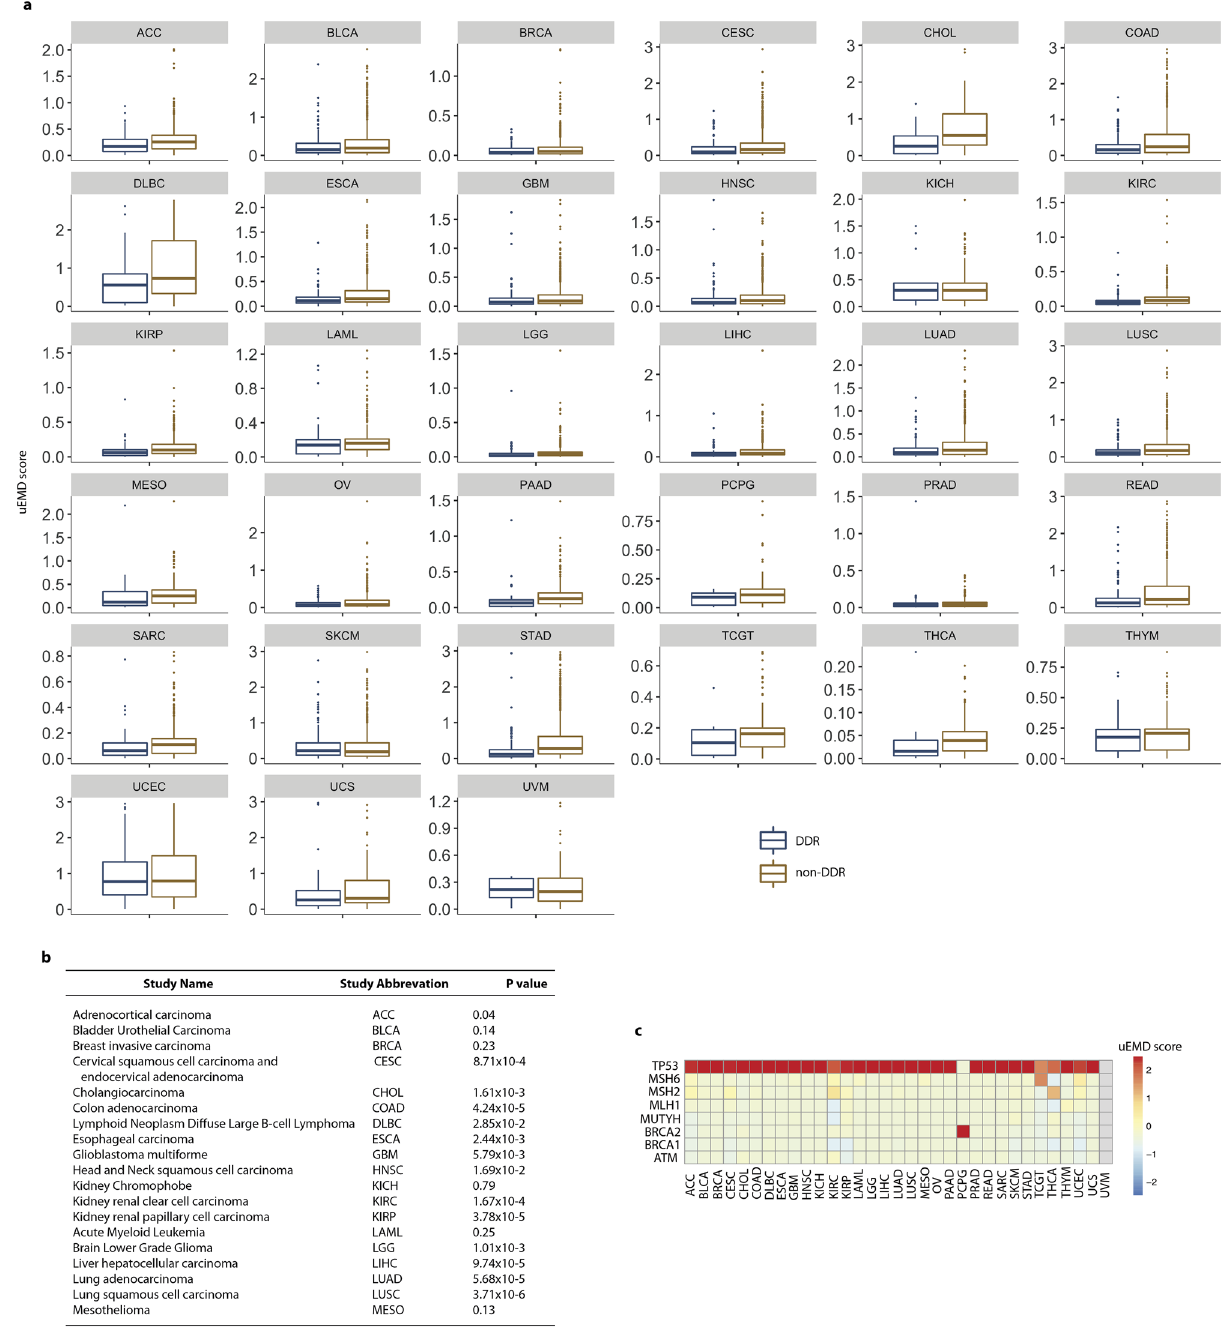
Figure 8. Study of DDR and non-DDR as cancer drivers across 33 tumour types. Panel ( a ) shows the DiffMut uEMD scores for the DDR and non-DDR genes across 33 tumour types studied in TCGA. BoxPlots indicate the 25th and 75th percentiles (box extent) and the median (centre line of each box). The whiskers extend from the hinge to the largest value no further than 1.5 × interquartile range from the hinge. Dots represent uEMD scores. The uEMD scores higher than 3 were excluded from the representation for clarity. Panel ( b ) shows P-values comparing DDR versus non-DDR genes based on the Wilcoxon rank-sum test. Panel ( c ) shows a heatmap of uEMD scores obtained by the different studies for the cancer-predisposition genes ATM , BRCA1 , BRCA2 , MLH1 , MSH2 , MSH6, and TP53